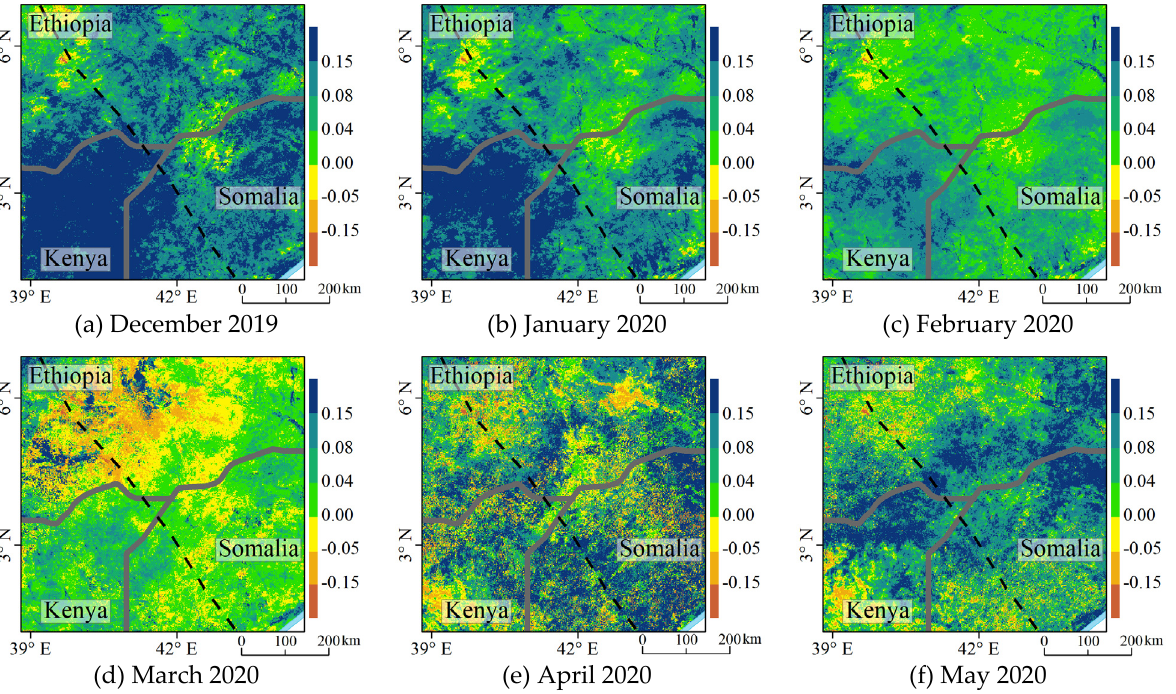
Figure 6. Spatial–temporal patterns of NDVI anomalies in E-S-K border region from December 2019 to May 2020. 3.2.2. NDVI Anomalies in the Indo-Pakistan Border Area According to the